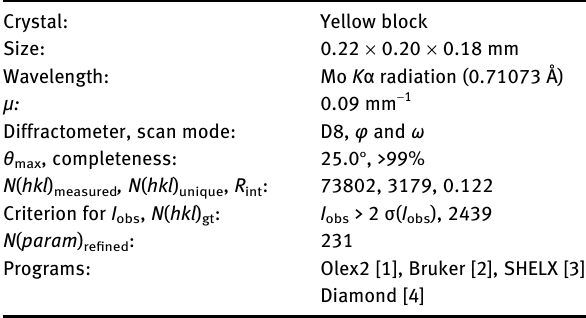
Table  : Data collection and